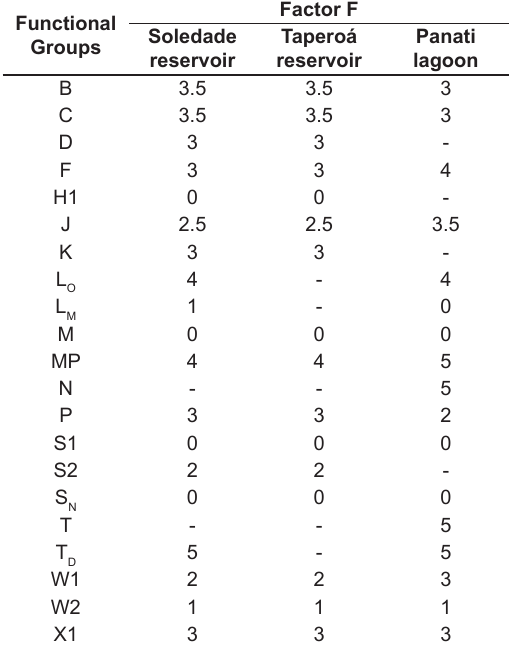
Table 3. Factor F weight to phytoplankton functional groups in three shallow aquatic ecosystems of semiarid region, Brazil.